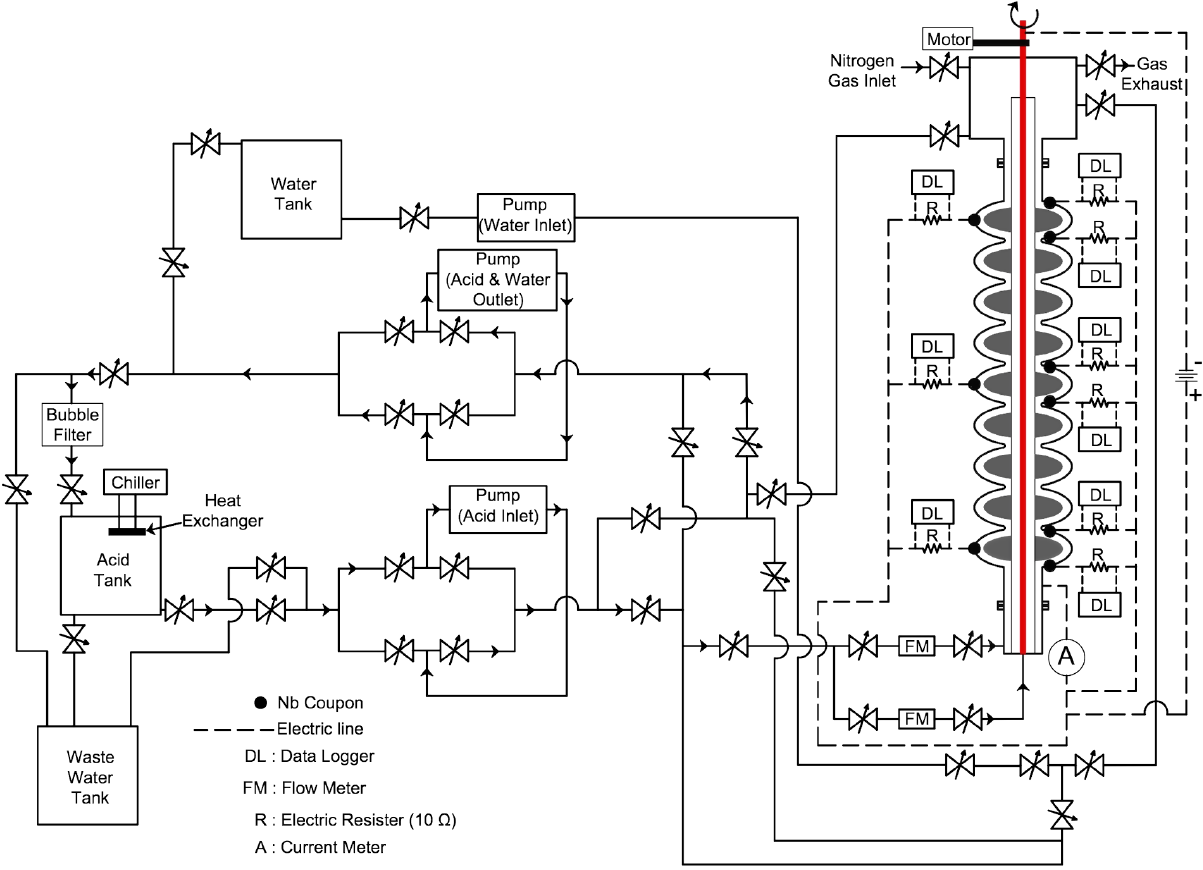
FIG. 3. Schematic of the acid and water flow unit used for VEP and water rinsing of the cavity. The dashed lines represent electric lines connected to the coupons, cavity, and cathode. The arrows indicate the acid flow direction in the VEP